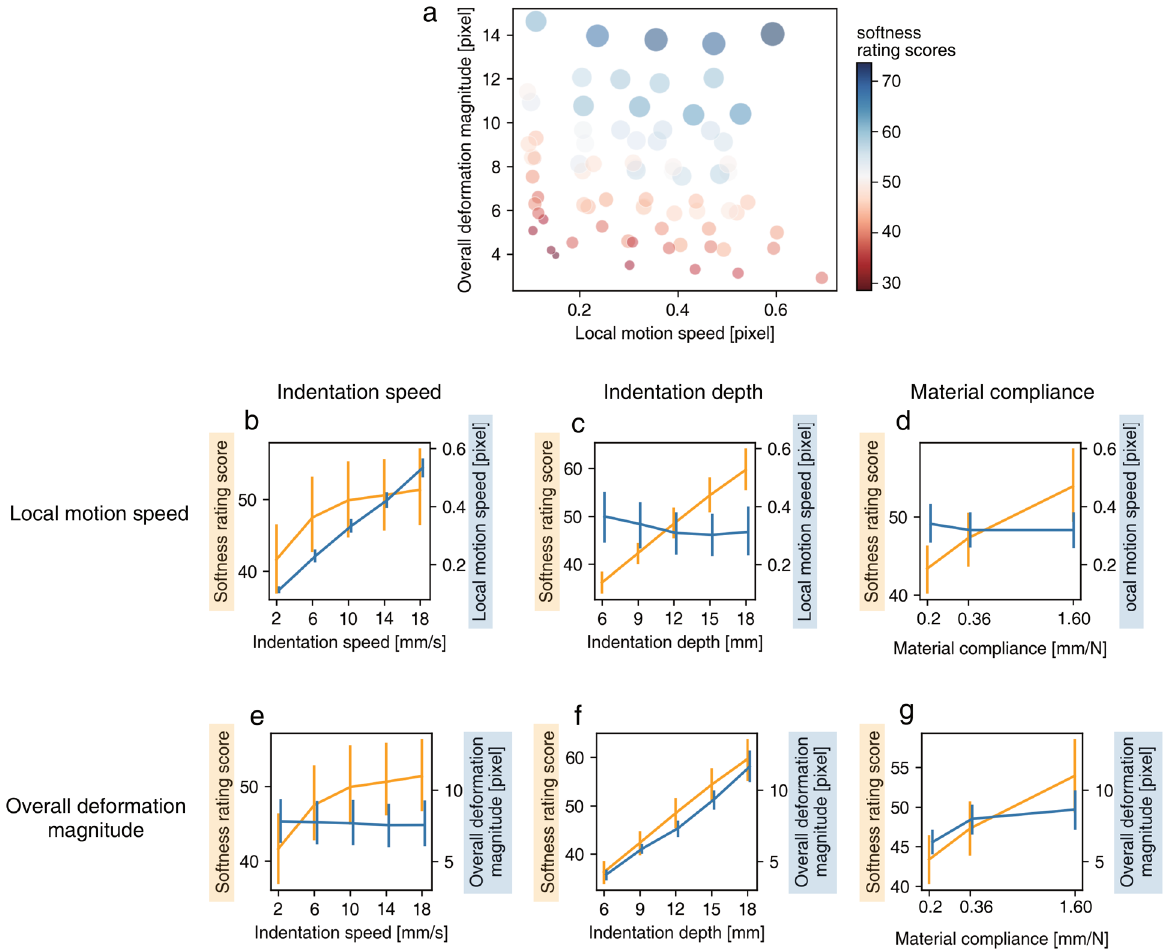
Figure 3. ( a ) Softness rating scores varied with image motion features. ( b – d ) Local motion speed as a function of ( b ) the indentation speed, ( c ) the indentation depth, and ( d ) material compliance. Blue lines denote local motion speed and orange lines denote softness rating scores. ( e – g ) Overall deformation magnitudes as a function of ( e ) the indentation speed, ( f ) the indentation depth, and ( g ) material compliance. Blue lines denote overall deformation magnitude and orange lines denote softness rating scores. Please note that the x-axes of ( d ) and ( g ) are a logarithmic scale. Error bars denote